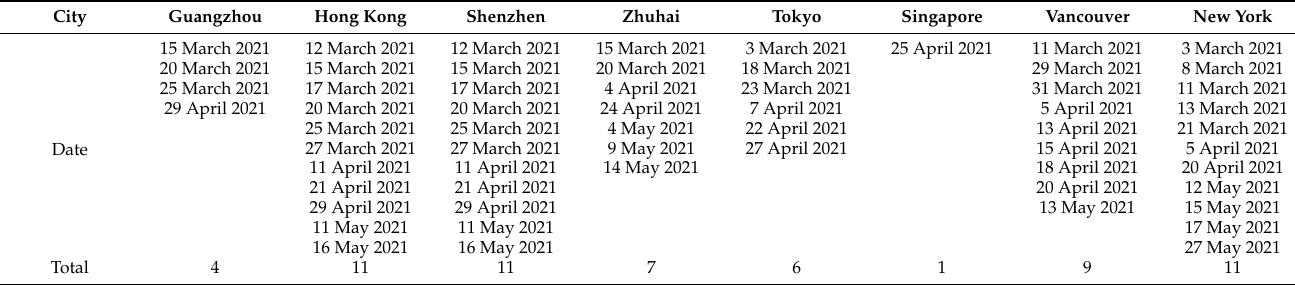
Table 1. The acquisition date and number of Sentinel-2